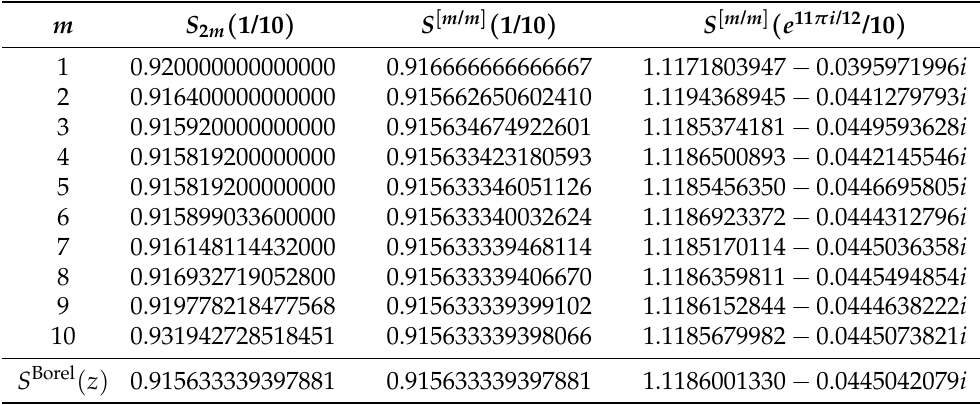
Table A1. Truncated sums and Padé approximants of the Stieltjes series are compared with the Borel sum. For z > 0, the Padé approximant quickly converges to the numerical value of the Borel sum, but it is not the case if z is near the branch cut z < 0 of the Borel